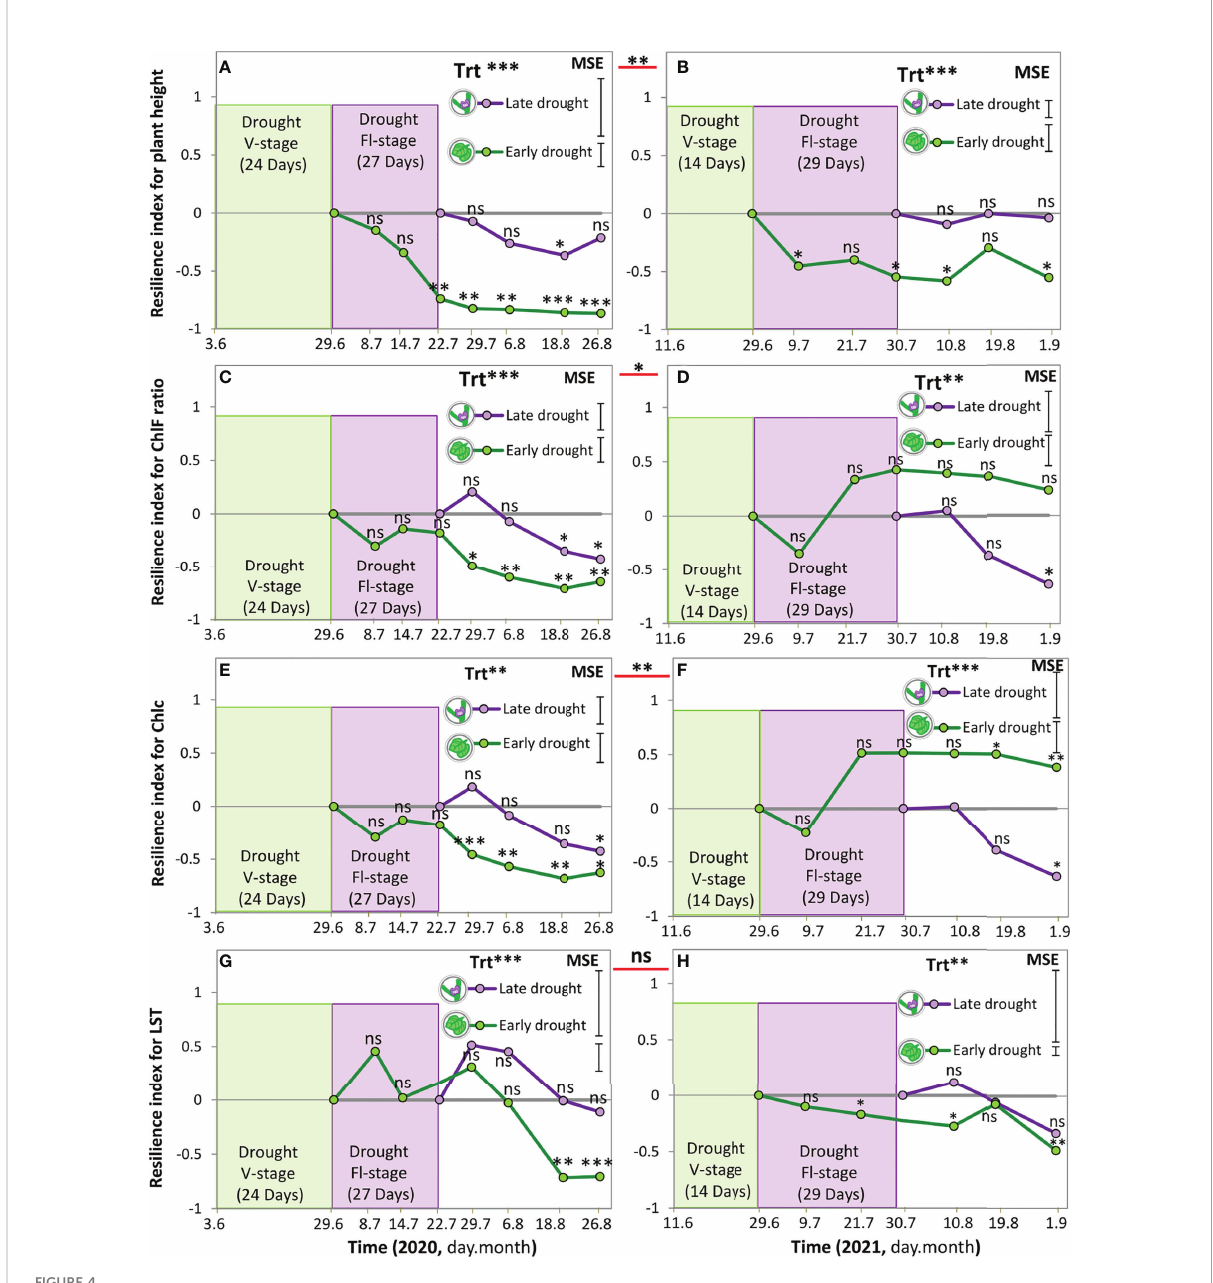
FIGURE 4 Resilience index for plant height (A, B) , chlorophyll fl uorescence ratio (C, D) , Chlorophyll content (E, F) , and leaf surface temperature (G, H) of soybean under four water treatments, 3 drought scenarios + the control (rainfed) treatments in 2020 (A,C,E, and G) and 2021 (B, D, F, H) ; equation 1. The green shaded area indicates the duration of the early drought event at the vegetative stage (V-stage) and the violet shaded area indicates the duration of the late drought event at the fl owering stage (Fl-stage). The vertical bars represent Tukey ’ s HSD test (p < 0.05) of the mean standard error (n = 3). Asterisks beside the factor treatment (Trt) indicate signi fi cant differences between the resilience at early drought and late drought based on ANOVA result; *** P < 0.001, ** P < 0.01, * P < 0.05, ns; not signi fi